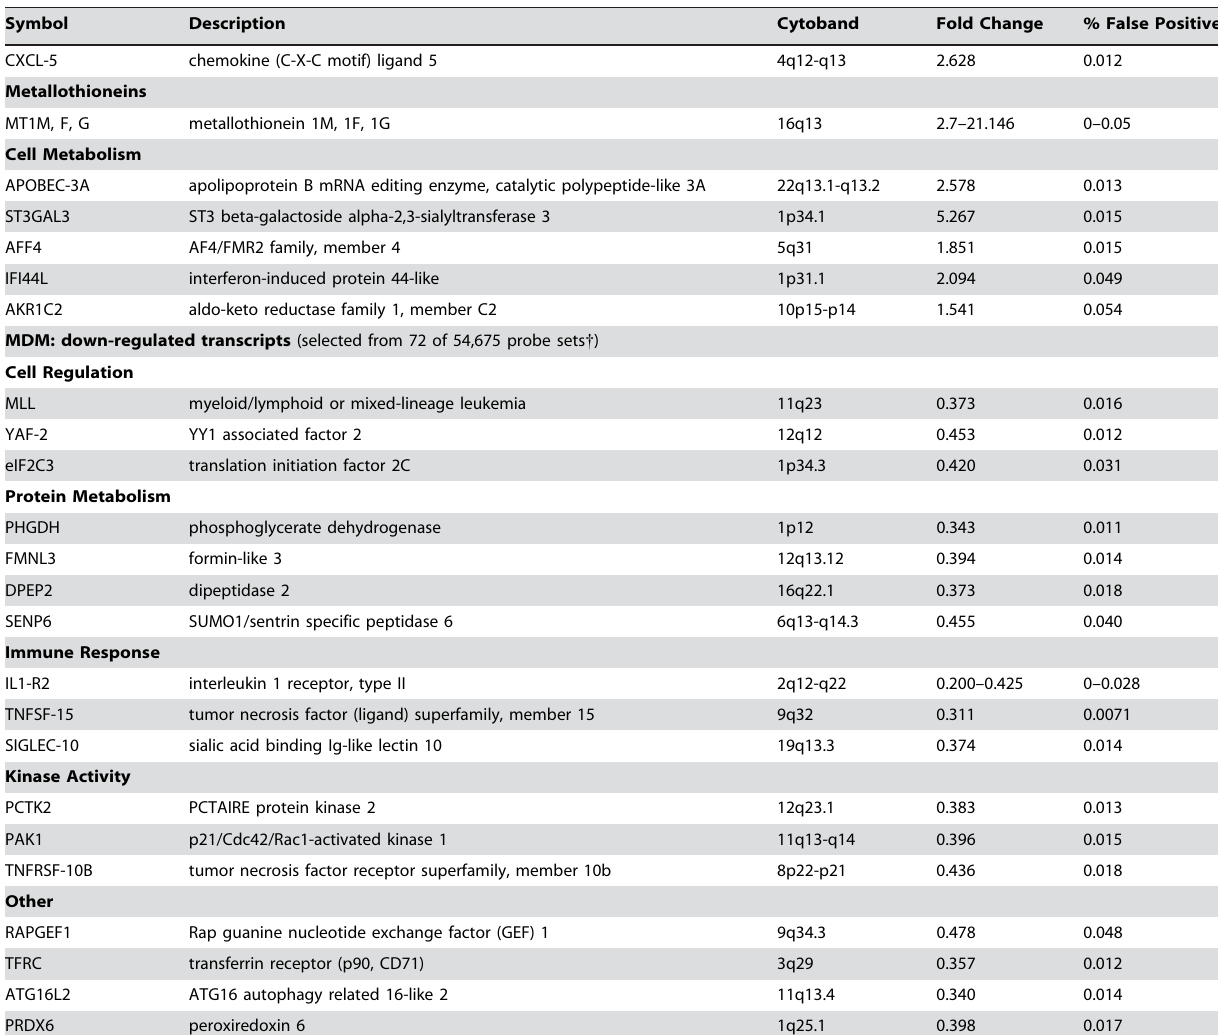
MDM: up-regulated transcripts (9 of 54,675 probe sets {